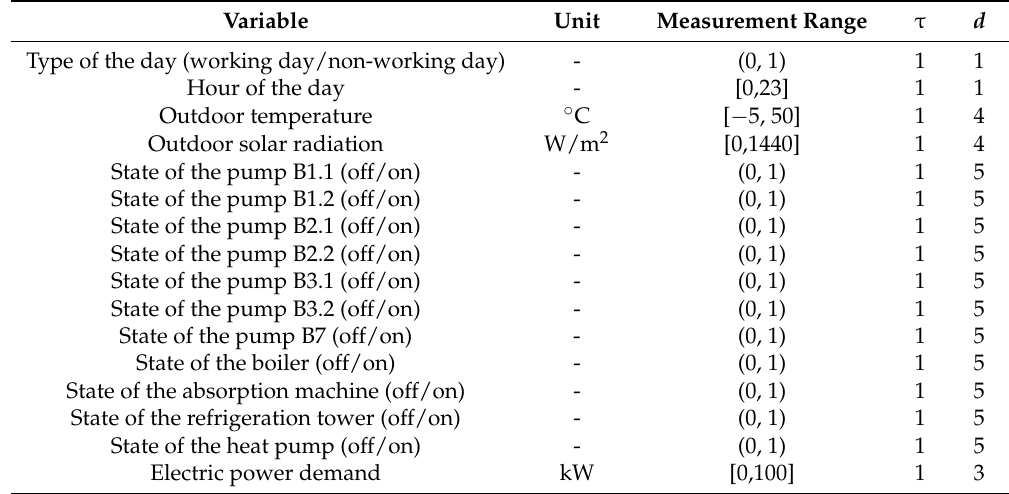
Table 3. Final list of variables with their order (embedding delay and dimension).